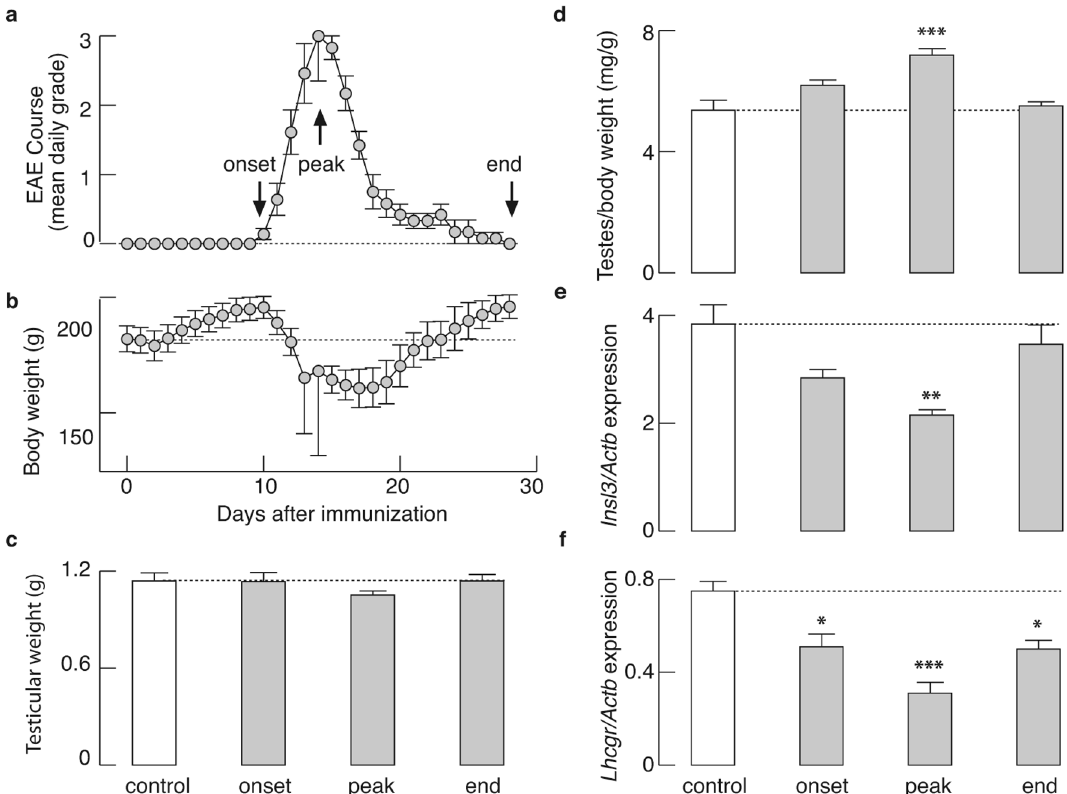
Figure 1. EAE course with simultaneous weight loss, without affecting testicular weight, but coinciding with changes in Insl3 and Lhcgr expression in testicular tissue. ( a , b ) Male rats (n = 18) were graded based on the severity of EAE symptoms ( a ), and weighed ( b ) every morning for 28 days after immunization. Regardless of the body weight loss, no significant difference in testicular weight was observed, as shown on ( c ), Mean left testicular weight on the day of euthanasia for each group of animals (n = 6 per group) and ( d ), Mean ratio between testicular weight vs. body weight on the day of euthanasia of the same animals; ( e ) Down-regulation in the expression of Insl3 in testicular tissue, determined by qRT-PCR, was noticeable and statistically significant at the peak of EAE, compared to control; ( f ) Down-regulation of Lhcgr mRNA, significant throughout the disease. The data shown are mean ± SEM (n = 6 animals/group), derived from a representative experiment. * P < 0.05, ** P < 0.01, *** P < 0.001; Kruskal–Wallis test, followed by Dunn’s post hoc test. The figure was made using KaleidaGraph (version 4.1.0; http:// www. syner gy. com) and Illustrator (version 25.1.0; http:// www. adobe.